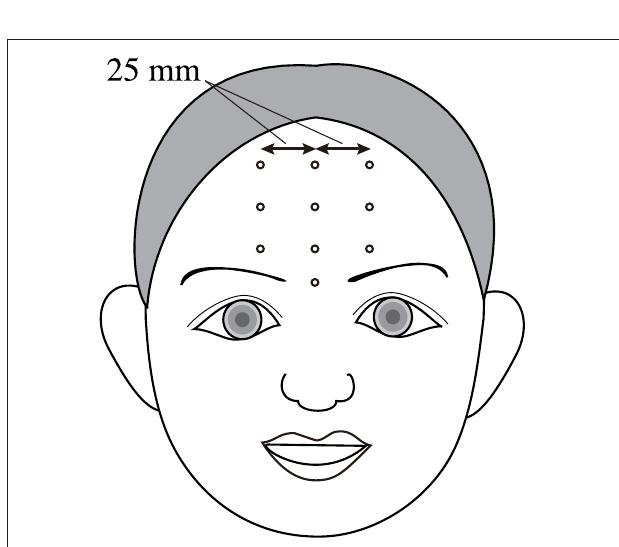
FIGURE 3 | Ten points used for vibration velocity